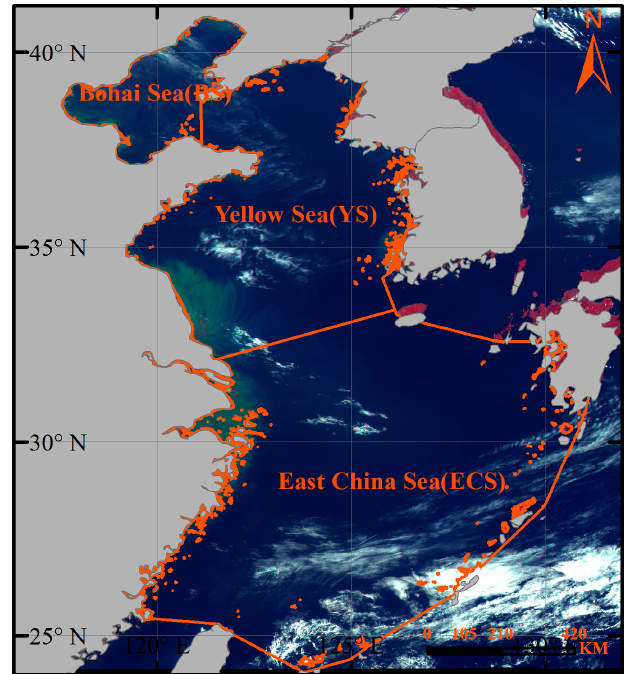
Figure 1. Map of the study area. The red–green–blue (RGB) image shows observations from the Geostationary Ocean Color Imager (GOCI) on 13 May, 2017.